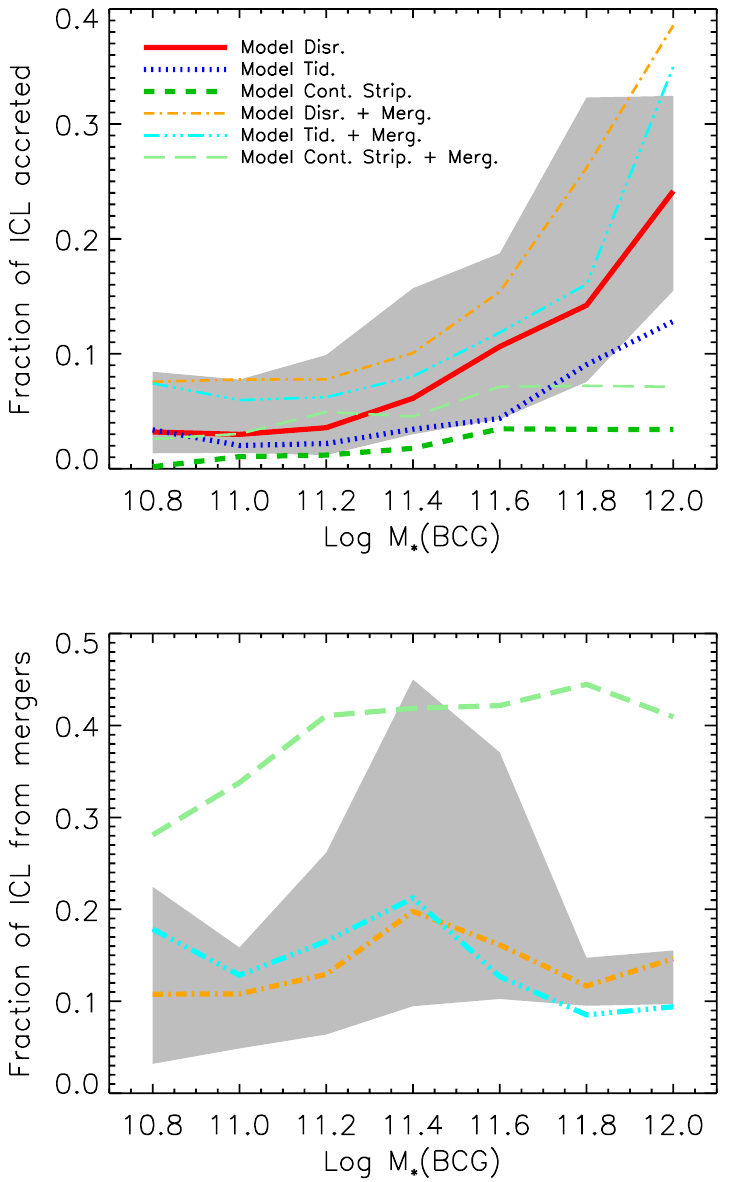
Figure 5. Top panel: fraction of ICL that has been accreted as a function of the mass of the BCG for different flavors of the model described by Contini et al. [4]. Bottom panel: fraction of the ICL coming from the merger channel as a function of BCG stellar mass. Credit: Contini et al.